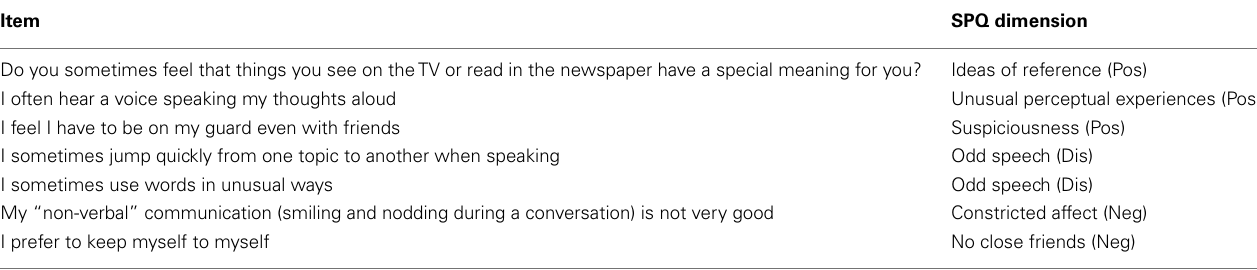
Table 1 | Sample Questionnaire Items for the measurement of